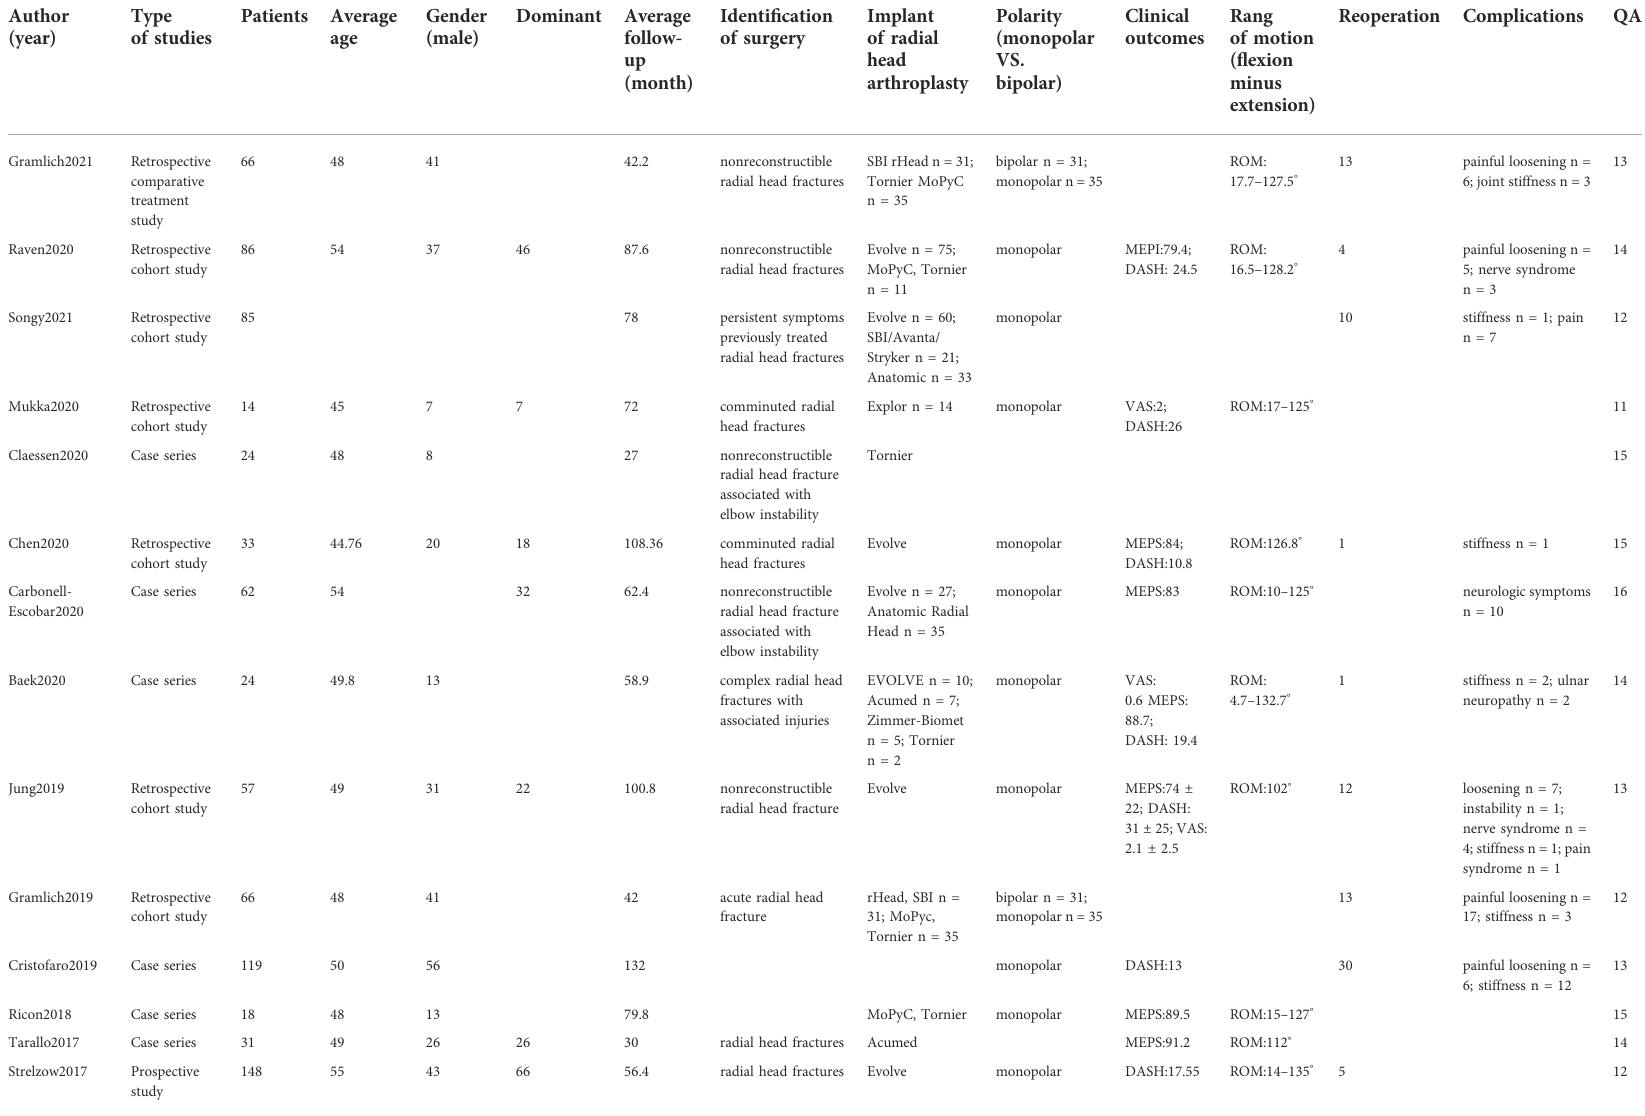
TABLE 2 Baseline demographics of the selected studies for uncemented fi xation. Author (year)